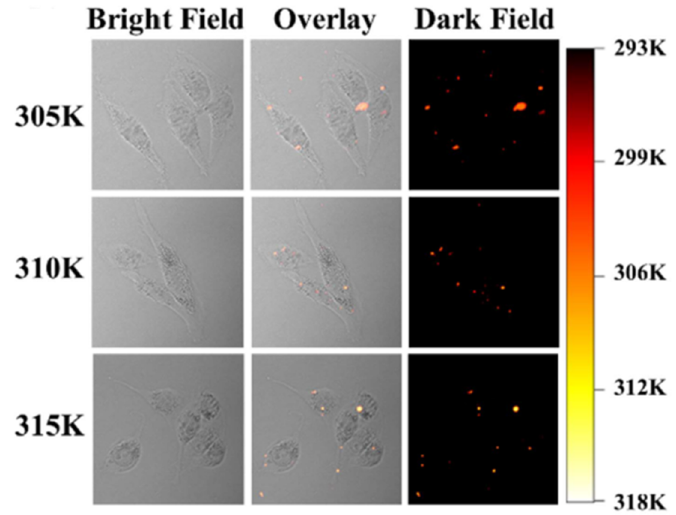
Figure 5. Thermal images of NIH-3T3 cells treated with external heating [100]. Adapted from [100] with permission from IOPScience. Copyright 2018 IOPScience.